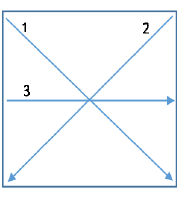
Figure 2. Electrical resistivity measuring lines/distances; 1 (5.7 cm), 2 (5.7 cm) and 3 (4 cm).